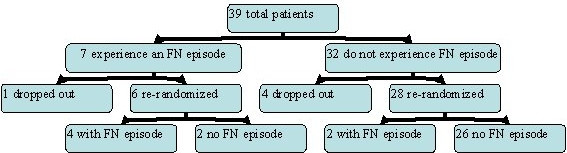
Chouaid et al. study